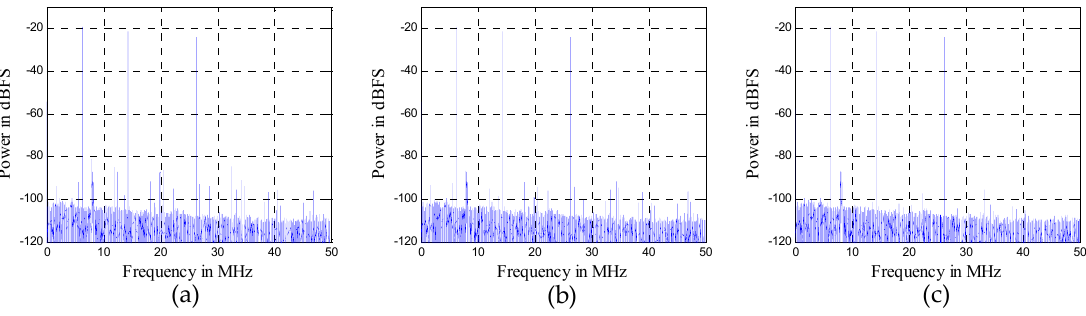
Figure 15. Simulation results with a 3-tone interferer signal with a weak 16-QAM signal: ( a ) distorted signal; ( b ) output of AIC algorithm; ( c ) output of the proposed algorithm.